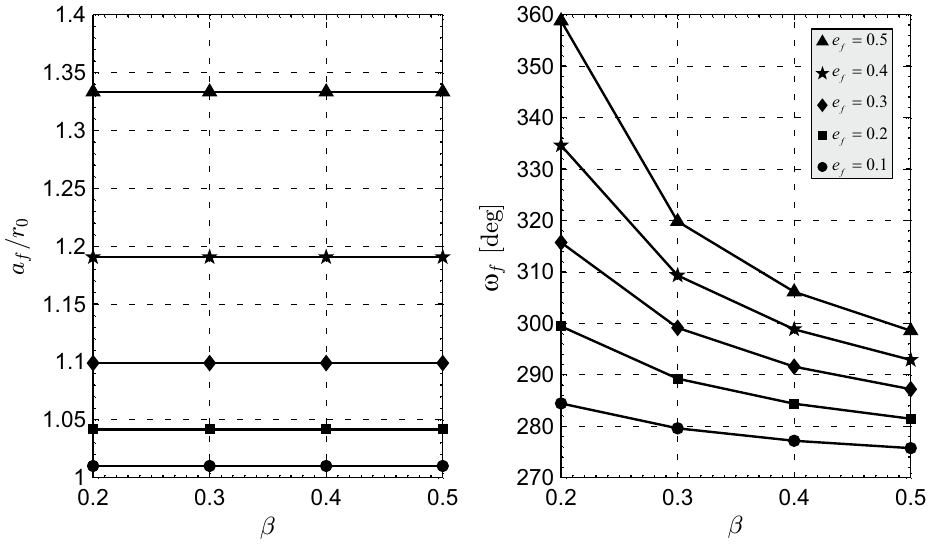
Figure 4. Geometric characteristics of target elliptic orbit as a function of e f and β .